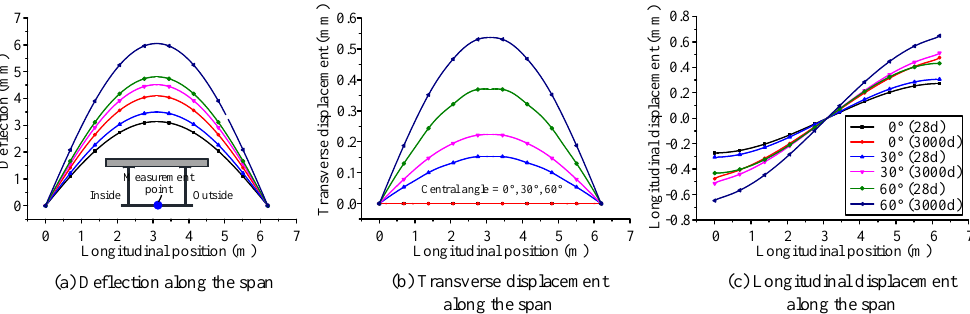
The compressive stress reduction rates at the inside of the concrete slab for central angles of 0°, 30°, and 60° are 58.8%, 57.8%, and 53.0%, respectively.